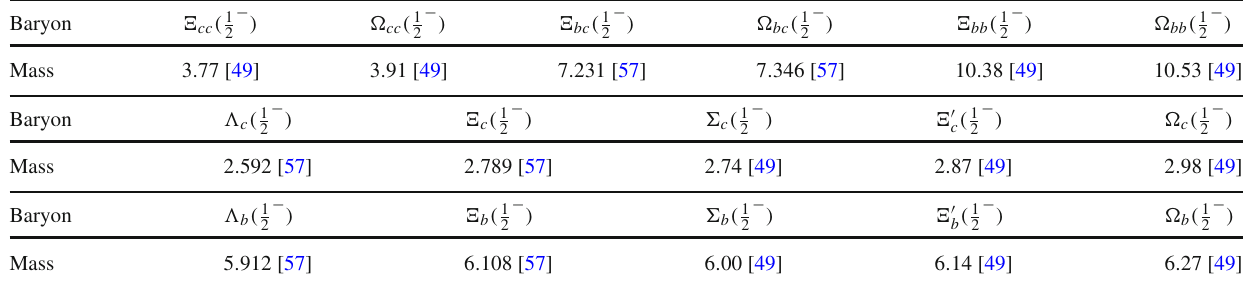
Table 3 Masses (in units of GeV) of the negative-parity baryons [49,57]